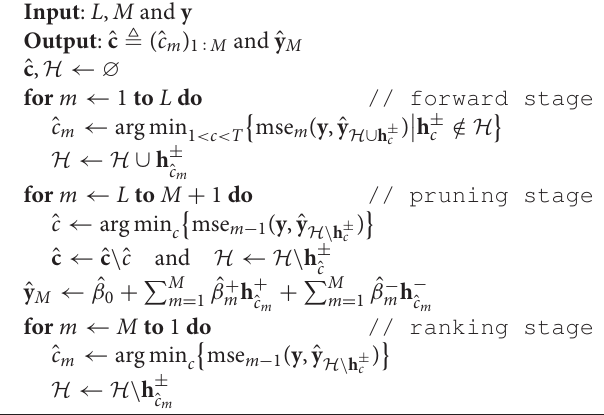
Algorithm 2: Identifying the order q of the MA